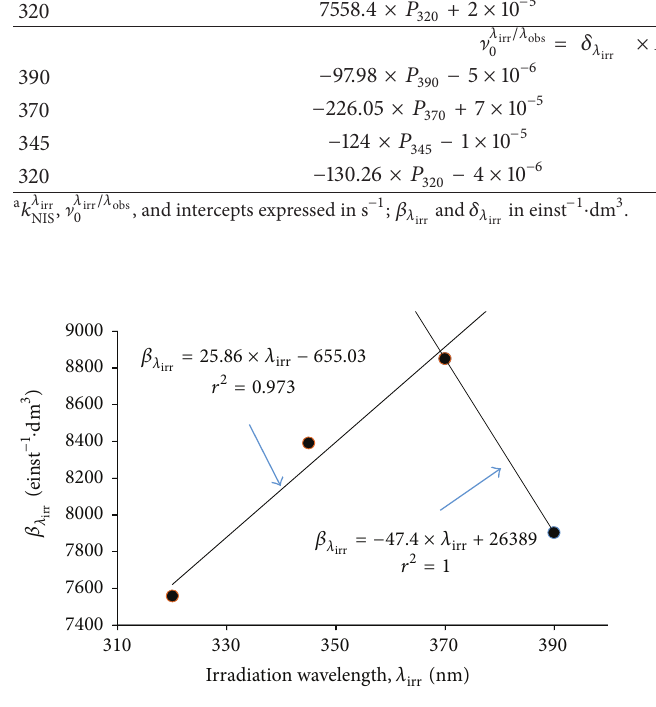
Table 4: Correlation equations for the variation of NIS photodegradation overall rate-constants (𝑘 𝜆 irr ), the corresponding 𝛽 𝜆 and 𝛿 𝜆 factors, and the span of radiant power employed for various monochromatic with radiant power ( 𝑃 𝜆 irr irr irr irradiations.